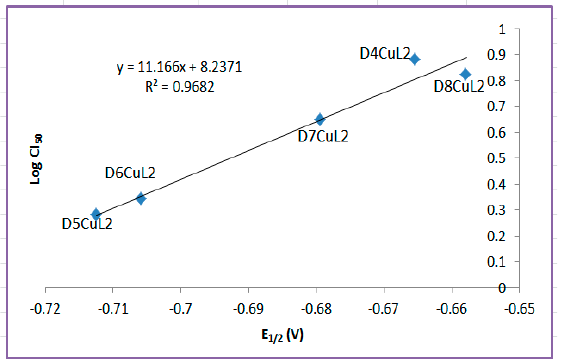
Figure 13. Relationship between redox potential and antiproliferative activity of copper(II) coordi- nation compounds with curcumin with CI 50 in HeLa.